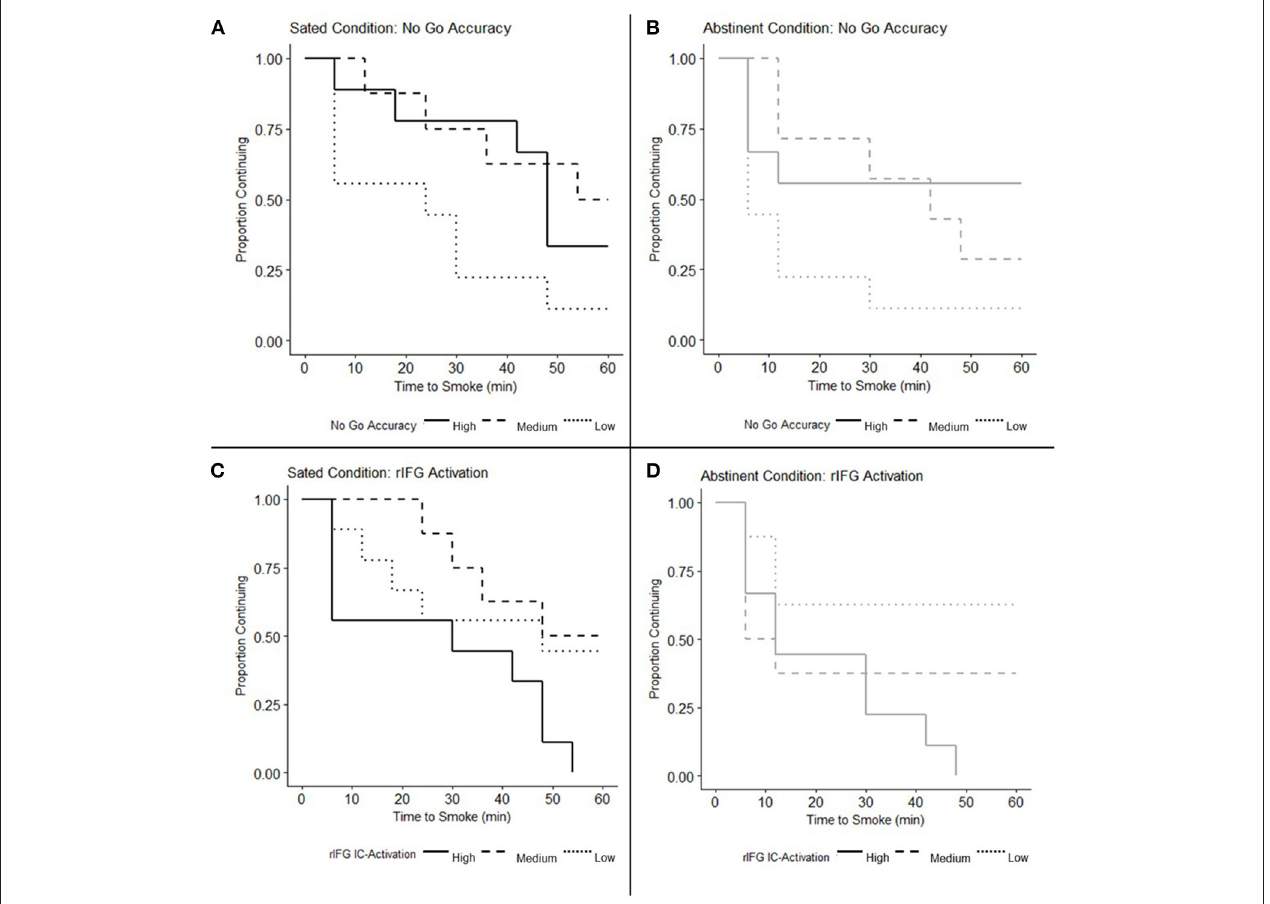
FIGURE 2 | No Go accuracy and inhibitory control (IC) activation in right inferior frontal gyrus (rIFG) related to smoking relapse analog task (SRT) performance. (A,B) Survival curves depicting Time to Smoke on the SRT under the (A) Sated condition ( N = 26) and (B) Abstinent condition ( N = 25) are stratified by participants with high, medium, and low No Go accuracy for illustrative purposes. Cox proportional hazards regression models reveal a significant main effect of No Go accuracy when collapsing across states ( p = 0.006), but indicate that No Go accuracy does not significantly predict time to smoke when examined under the Sated ( p = 0.083) and Abstinent conditions ( p = 0.057) alone. The main effect of state on SRT performance was non-significant ( p = 0.23) as was the interaction between No Go Accuracy and smoking state ( p = 0.25), indicating a similar relationship between No Go Accuracy and SRT performance across both states. (C,D) Survival curves